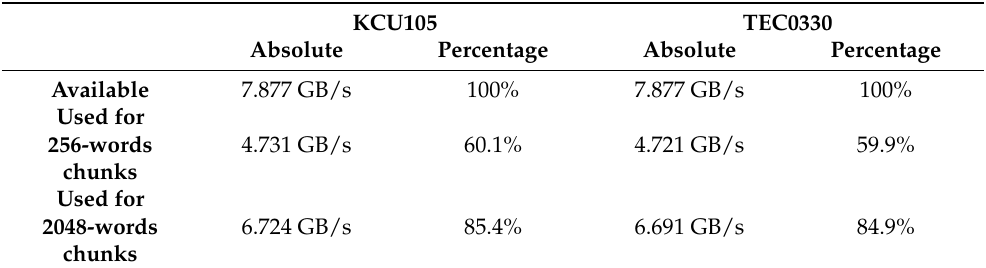
Table 2. Transmission speed and 8xGen3 PCI-Express bandwidth utilization in tested hardware